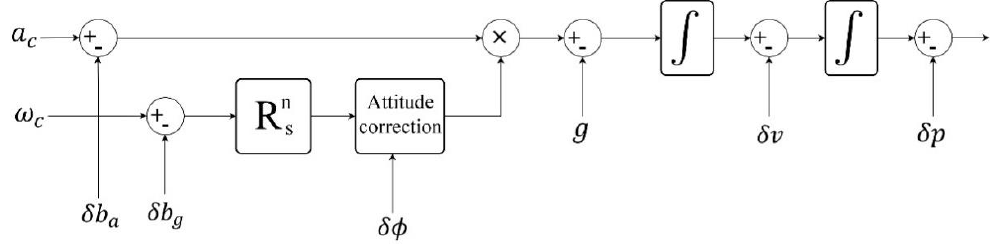
Figure 2. Foot-mounted INS kinematic flowgraph.